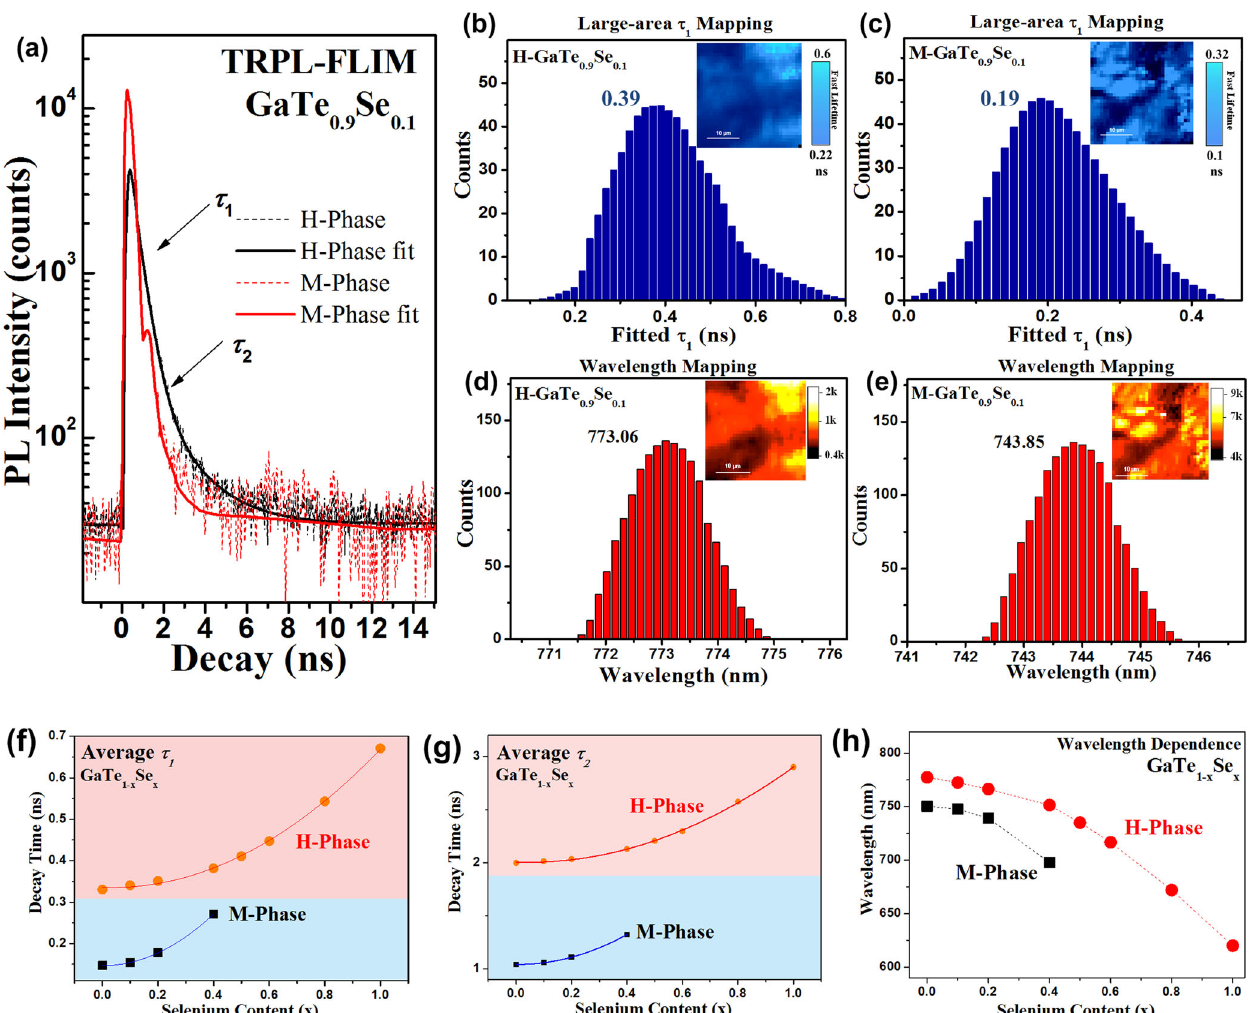
Fig. 3 The FLIM and AFWM results of layered GaTe 1-x Se x series. a Averaged TRPL decay curves of the H- and M-phase parts in multilayered GaTe 0.9 Se 0.1 within a scanned area of 300 × 300 μ m 2 at 300 K. The red and black lines are, respectively, the fi tted results of the H- and M-phase parts using Eq. (2). Analyses of ( b ) the FLIM histogram and ( c ) the FLIM distribution of τ 1 in H-GaTe 0.9 Se 0.1 and M-GaTe 0.9 Se 0.1 . d AFWM histogram and PL intensity distribution of H-GaTe 0.9 Se 0.1 . e AFWM histogram and PL intensity distribution of M-GaTe 0.9 Se 0.1 . Composition- dependent ( f ) faster recombination lifetime τ 1 and ( g ) slower recombination lifetime τ 2 detected in the full-series M-GaTe 1 − x Se x (0 ≤ x ≤ 0.4) and H-GaTe 1 − x Se x (0 ≤ x ≤ 1). ( h ) Composition-dependent emission wavelengths of full-series M-GaTe 1 − x Se x (0 ≤ x ≤ 0.4) and H-GaTe 1 − x Se x (0 ≤ x ≤ 1) obtained from the AFWM M-phase part (emission peak at 1.666 eV) and the hexagonal- plate-shaped H-phase part (emission peak at 1.608 eV) shown in Supplementary Fig. 5 in the SI. The results of the fl uorescence lifetime image mapping (FLIM) conducted in the TRPL experiment shown in Fig. 3a clearly indicate that the area-averaged TRPL spectrum of M-GaTe 0.9 Se 0.1 (red color) exhibits a much sharper and, hence, faster band-edge recombination lifetime τ 1 compared to that of H-GaTe 0.9 Se 0.1 (black color). The average value of the slower recombination lifetime τ 2 (defect related) of M-GaTe 0.9 Se 0.1 obtained using AFLM is also smaller than that of H-GaTe 0.9 Se 0.1 , similar to the single- point TRPL result of the x = 0.1 sample in Fig. 1g, h. Figure 3b shows the FLIM histogram and FLIM image of the faster time constant τ 1 in the scanned area (300 × 300 μ m 2 ) of the H-GaTe 0.9 Se 0.1 , where the center value is approximately 0.39 ns. The same TRPL analysis in Fig. 3c also revealed that the center value of τ 1 of M-GaTe 0.9 Se 0.1 is approximately 0.19 ns, which is faster than that of H-GaTe 0.9 Se 0.1 .